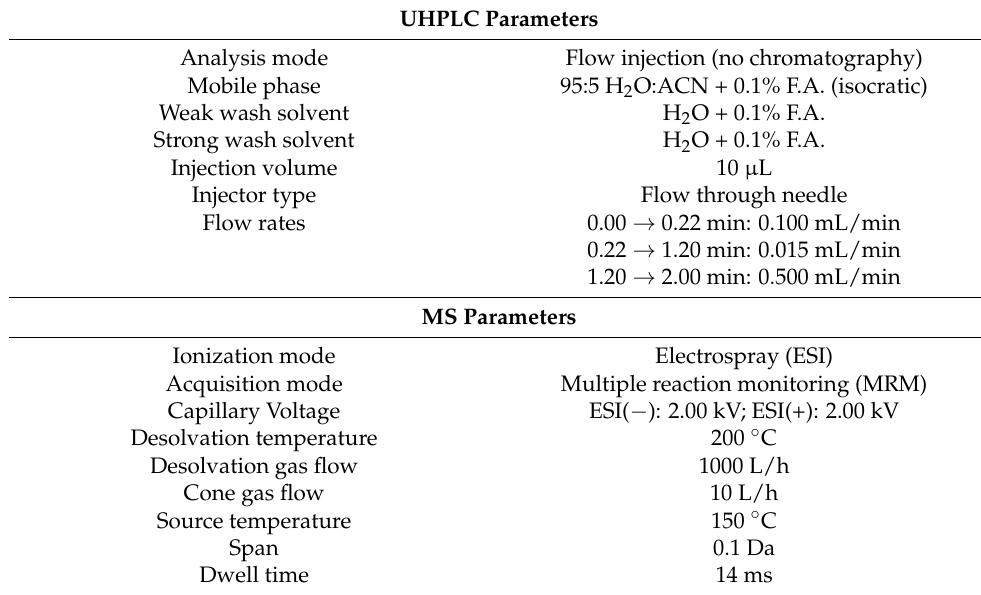
Table 2. UHPLC and MS parameters for the screening